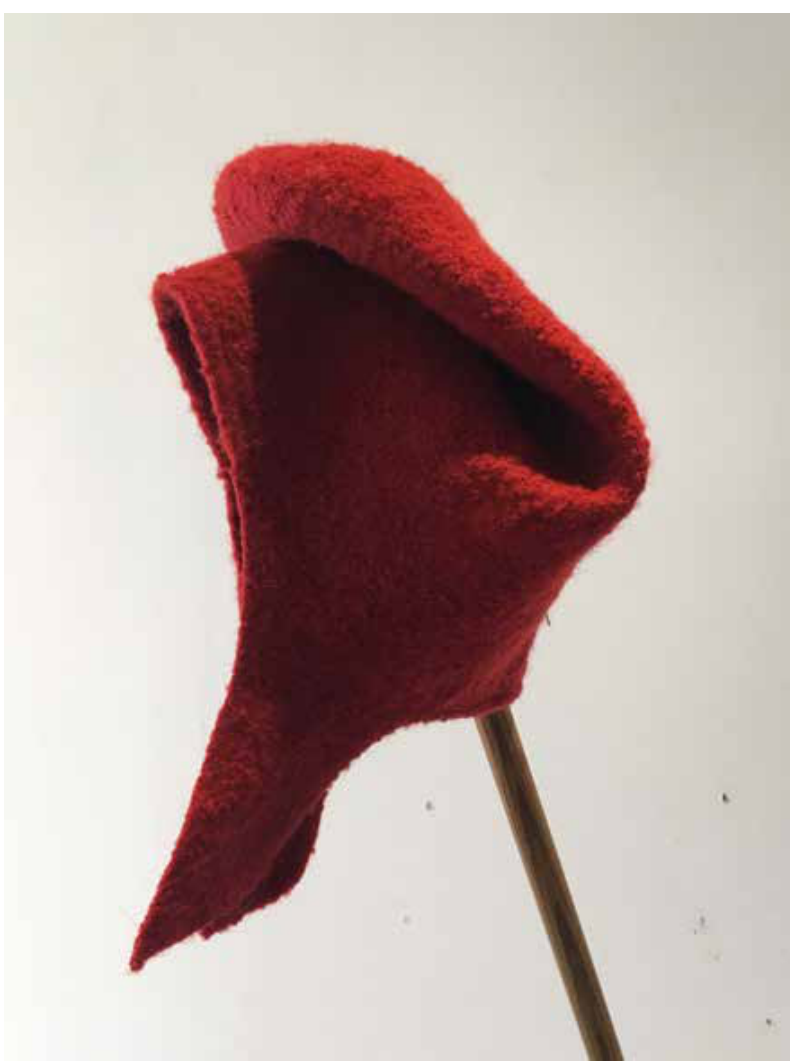
Figure 5: Jenny Roesel Ustick, Run It Up (detail), 2017. Felted wool, wood, and plaster. This hand- knit, felted cap is displayed on a tilted Liberty Pole. It acts as a complicated flag, representing the hope for freedom that is haunted by the possibility of surrender. The phrase “run it up” and its equally complicated multiple meanings serve at once as a plea to decency, a cynical dismissal, and a celebration of power and